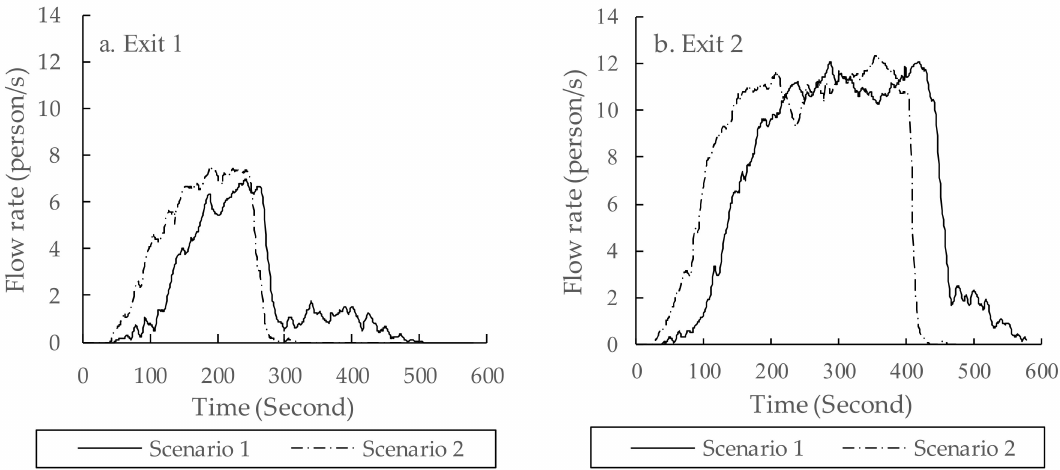
Figure 8. Flow rates of two exits under two scenarios. ( a ) The evacuation flow rate of the Southwest exit (exit 1); ( b ) the evacuation flow rate of the Southeast exit (exit